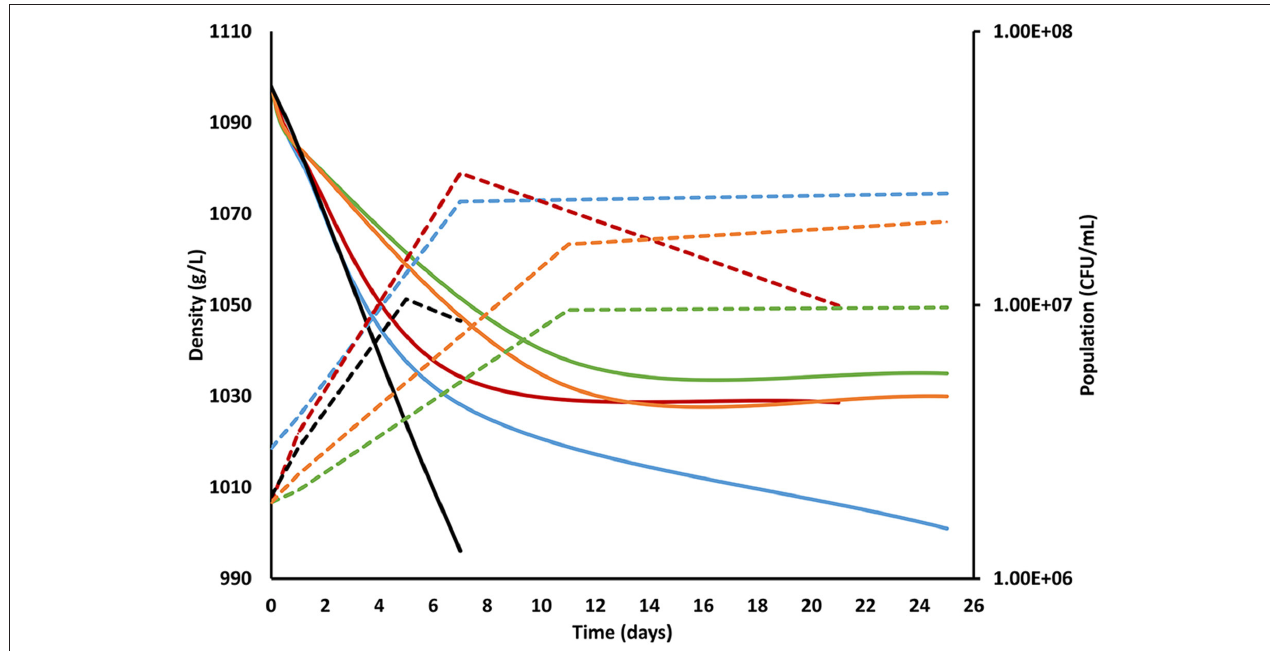
FIGURE 1 | Fermentation kinetics of the different inoculation strategies performed under 100N-240S nutrient conditions. The solid line shows the evolution of the fermentation measured by density (g/L) and the dotted line assessed by plate culturing in YPD (CFU/mL). The line color corresponds to each fermentation strategy: blue, co-inoculated fermentation; red, inoculation of S. cerevisiae at 24h; green, inoculation of S. cerevisiae at 48h; orange, inoculation of S. cerevisiae at 5 days, and black; control fermentation with only S. cerevisiae. Standard deviations were always lower than 10% and have been avoided in the figure for